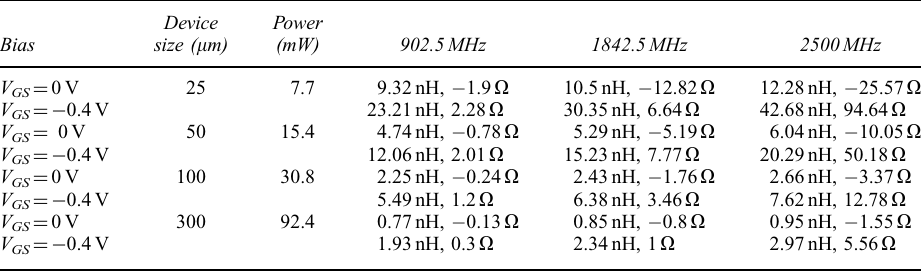
TABLE IV Inductance and Series Resistance of Inductor as a Function of Gate-Bias (T c ) and Device Gate-Width